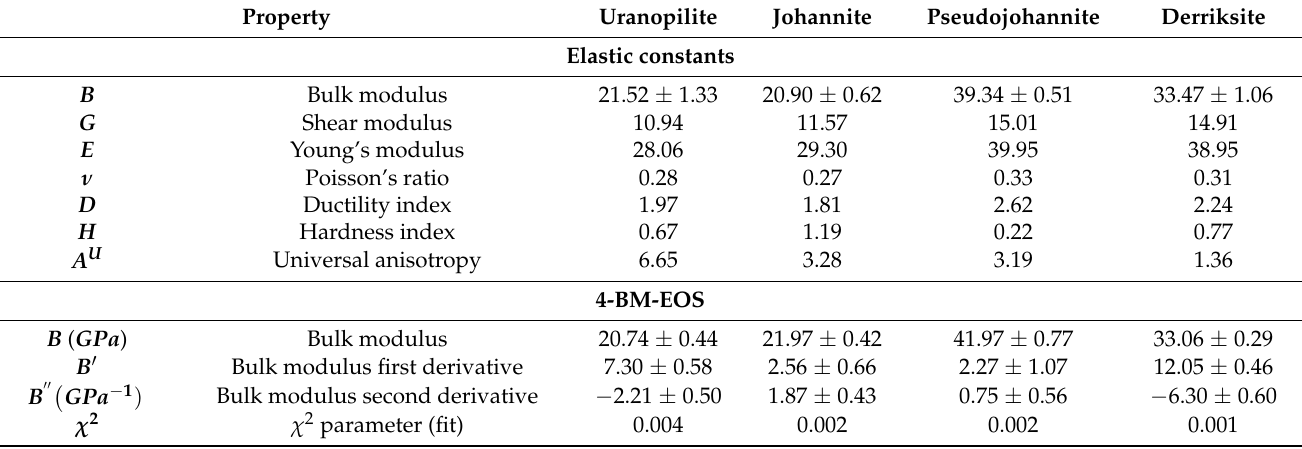
Table 6. Calculated mechanical properties of uranopilite, johannite, pseudojohannite and derriksite in the Reuss approximation. The values of the bulk, Young’s and shear moduli ( B , G and E ) are given in GPa units. The computed bulk modulus and its first two derivatives with respect to pressure derived from the 4-BM-EOS are also